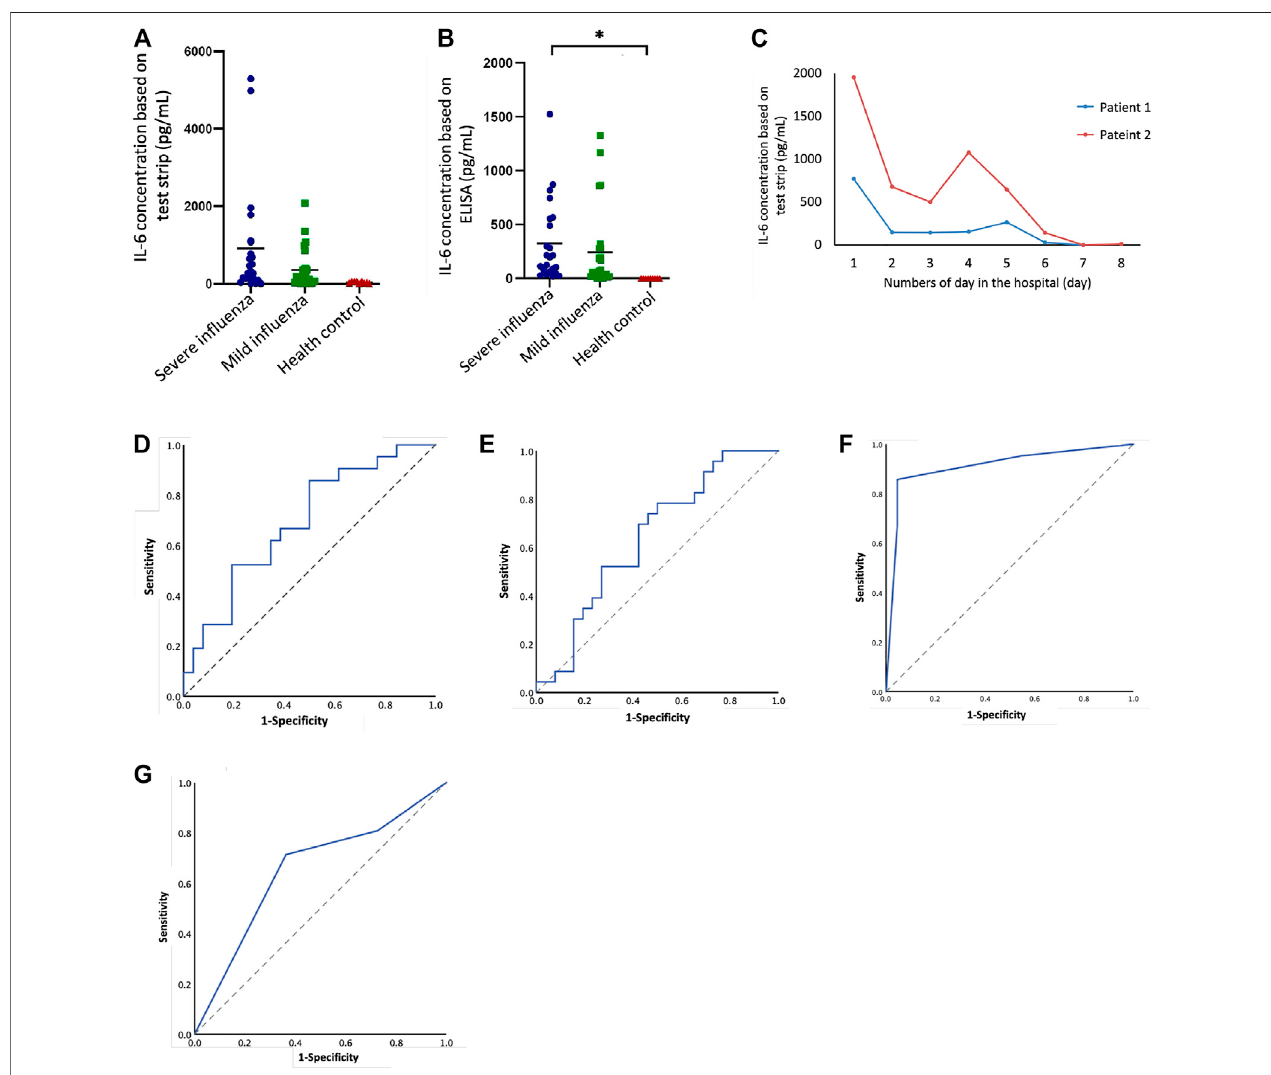
FIGURE3| IL-6 levels in severe cases and mild cases of in fl uenza in children based on test strip and ELISA. (A) IL-6 (test strip) concentration between different groups: severe in fl uenza (n (cid:1) 23), mild in fl uenza (n (cid:1) 26), health control (n (cid:1) 10). (B) IL-6 (ELISA) concentration between different groups: severe in fl uenza (n (cid:1) 23), mild in fl uenza (n (cid:1) 26), health control (n (cid:1) 10). Therewas a statistically signi fi cant difference between severe cases and healthy controls( p < 0.05). (C) Follow-up IL-6 test strip concentrations compared to number of days in the hospital for two patients. (D) ROC curve of IL-6 concentration (test strip), AUC (cid:1) 0.69, p (cid:1) 0.026. (E) ROCcurveofIL-6 concentration (ELISA), AUC (cid:1) 0.64, p (cid:1) 0.092. (F) ROC curve ofIL-6 concentration(test strip) combined with CRP, AUC (cid:1) 0.911, p (cid:1) 0.00. (G) ROC curve of IL-6 concentration (ELISA) combined with CRP, AUC (cid:1) 0.654, p (cid:1) 0.085.